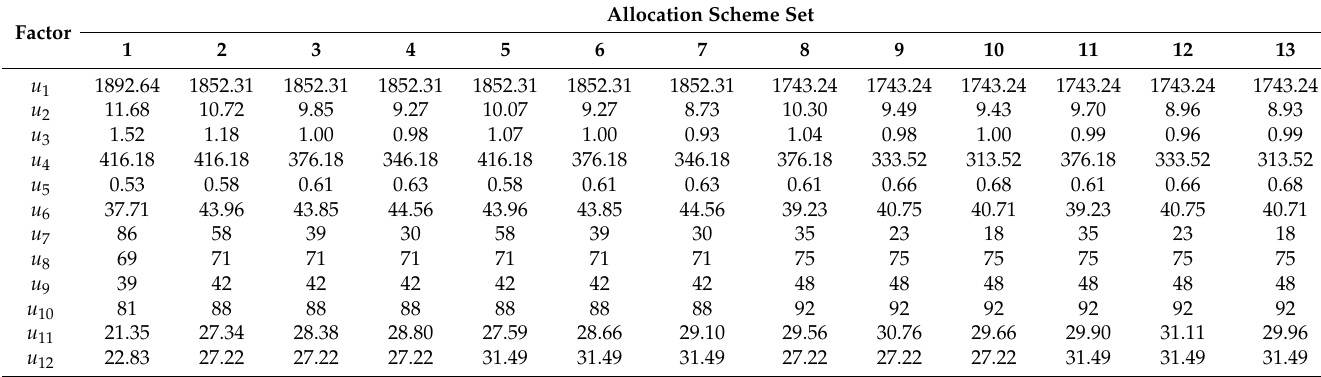
Table 6. Statistics of the evaluation factors based on the water resource allocation scheme